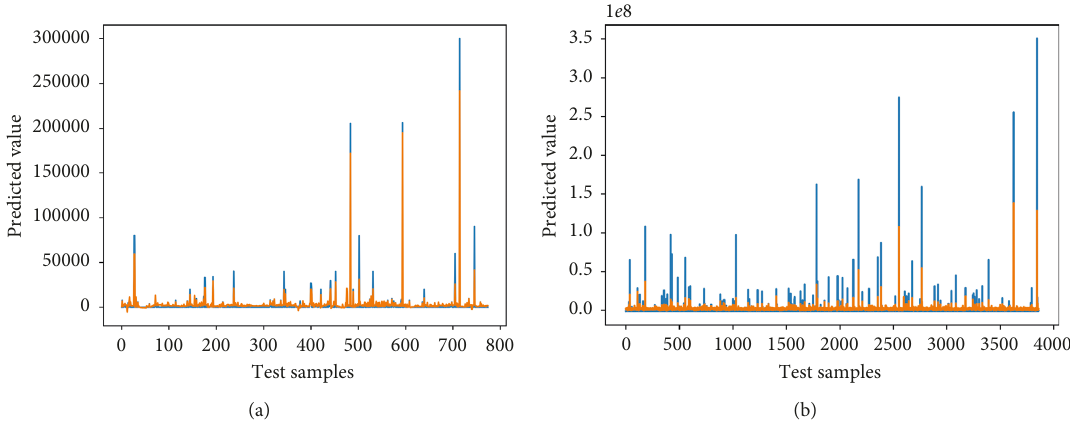
Figure 10: Testing performance of LSTM on (a) UCI seismic bumps and (b) AAIA ′ 16